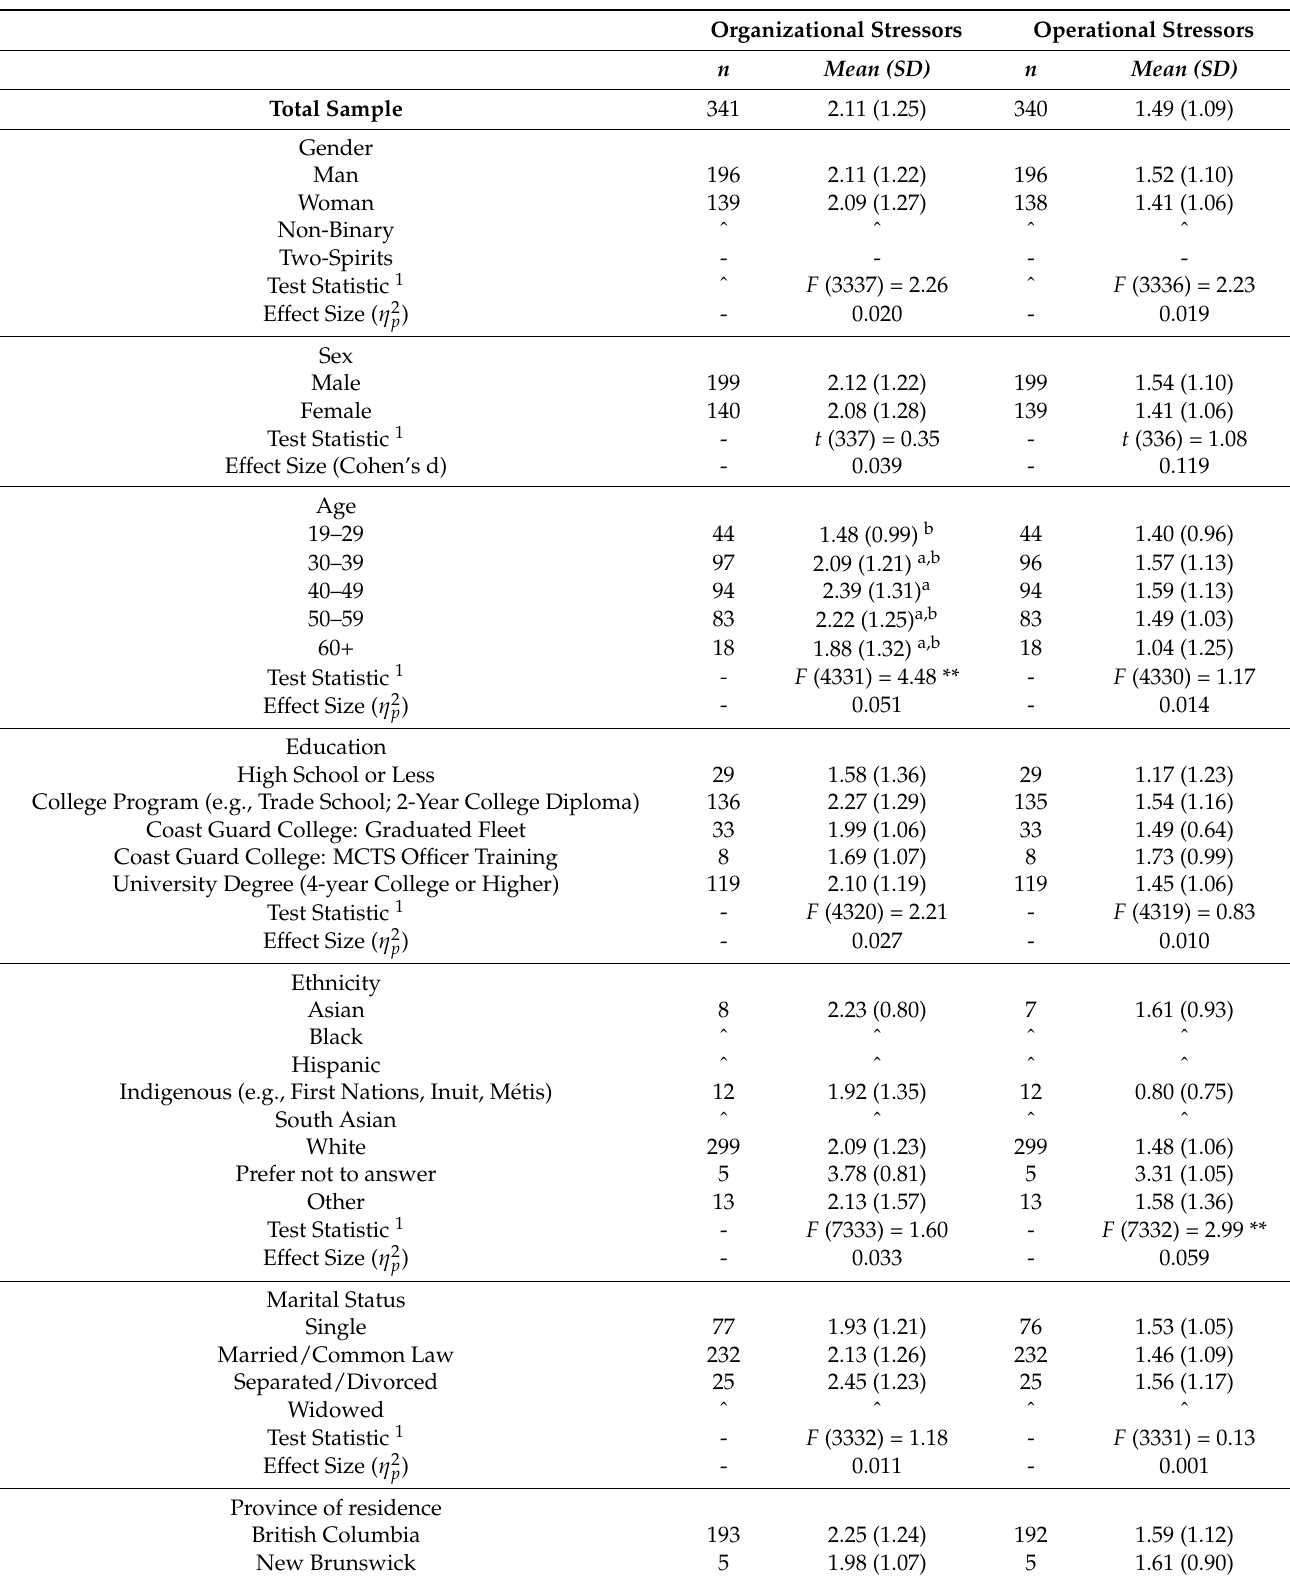
Table 2. Occupational Stressors Levels across Participant Demographics